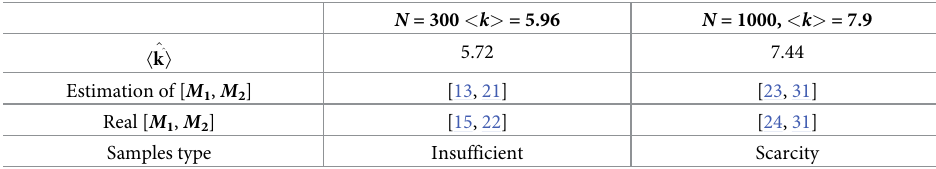
Table 3. The judgement of sample capacity (20